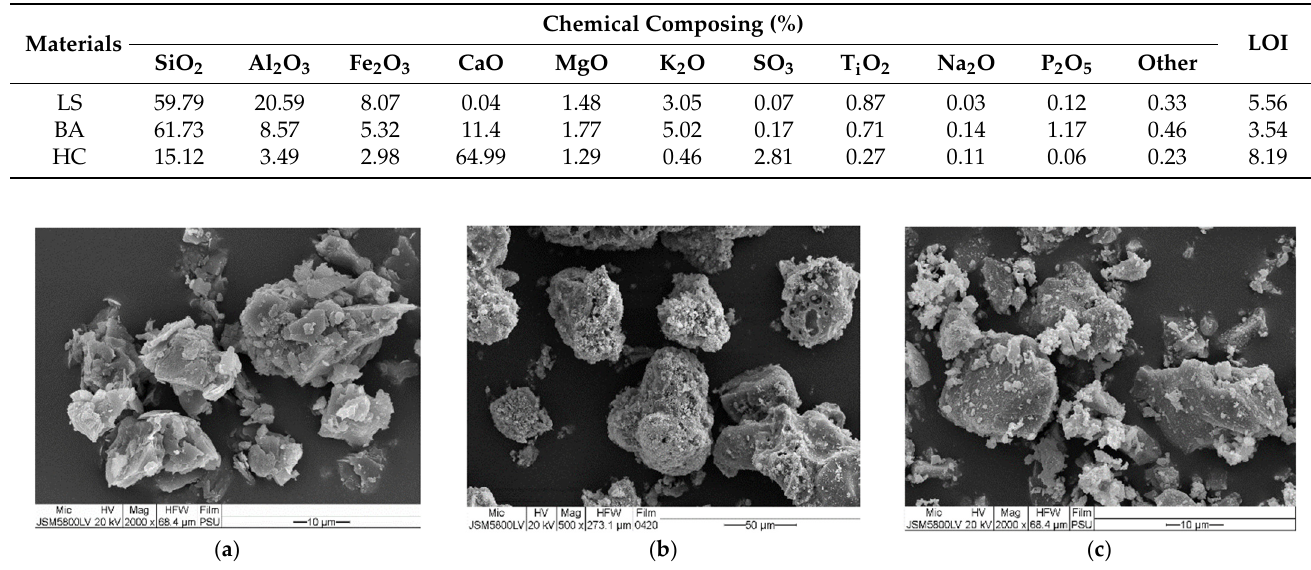
Table 2. Chemical compositions of the LS, BA, and HC.